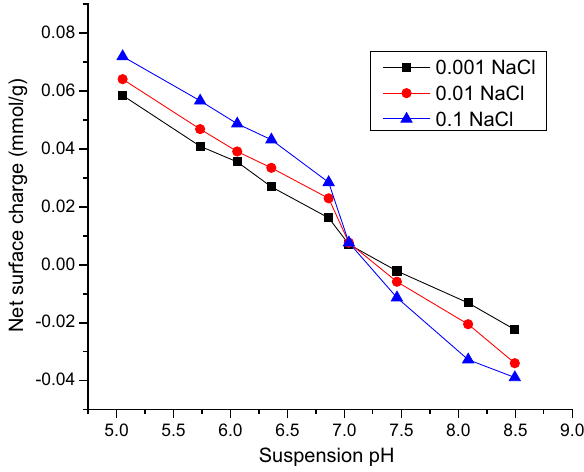
Fig. 4 Point of zero salt effect of kaolinite (Egirani et al. 2017a)